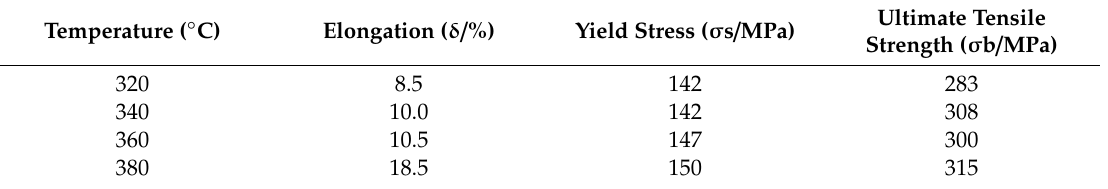
Table 8. Tensile properties of the isothermal forging parts at di ff erent temperatures. Temperature ( ◦ C)